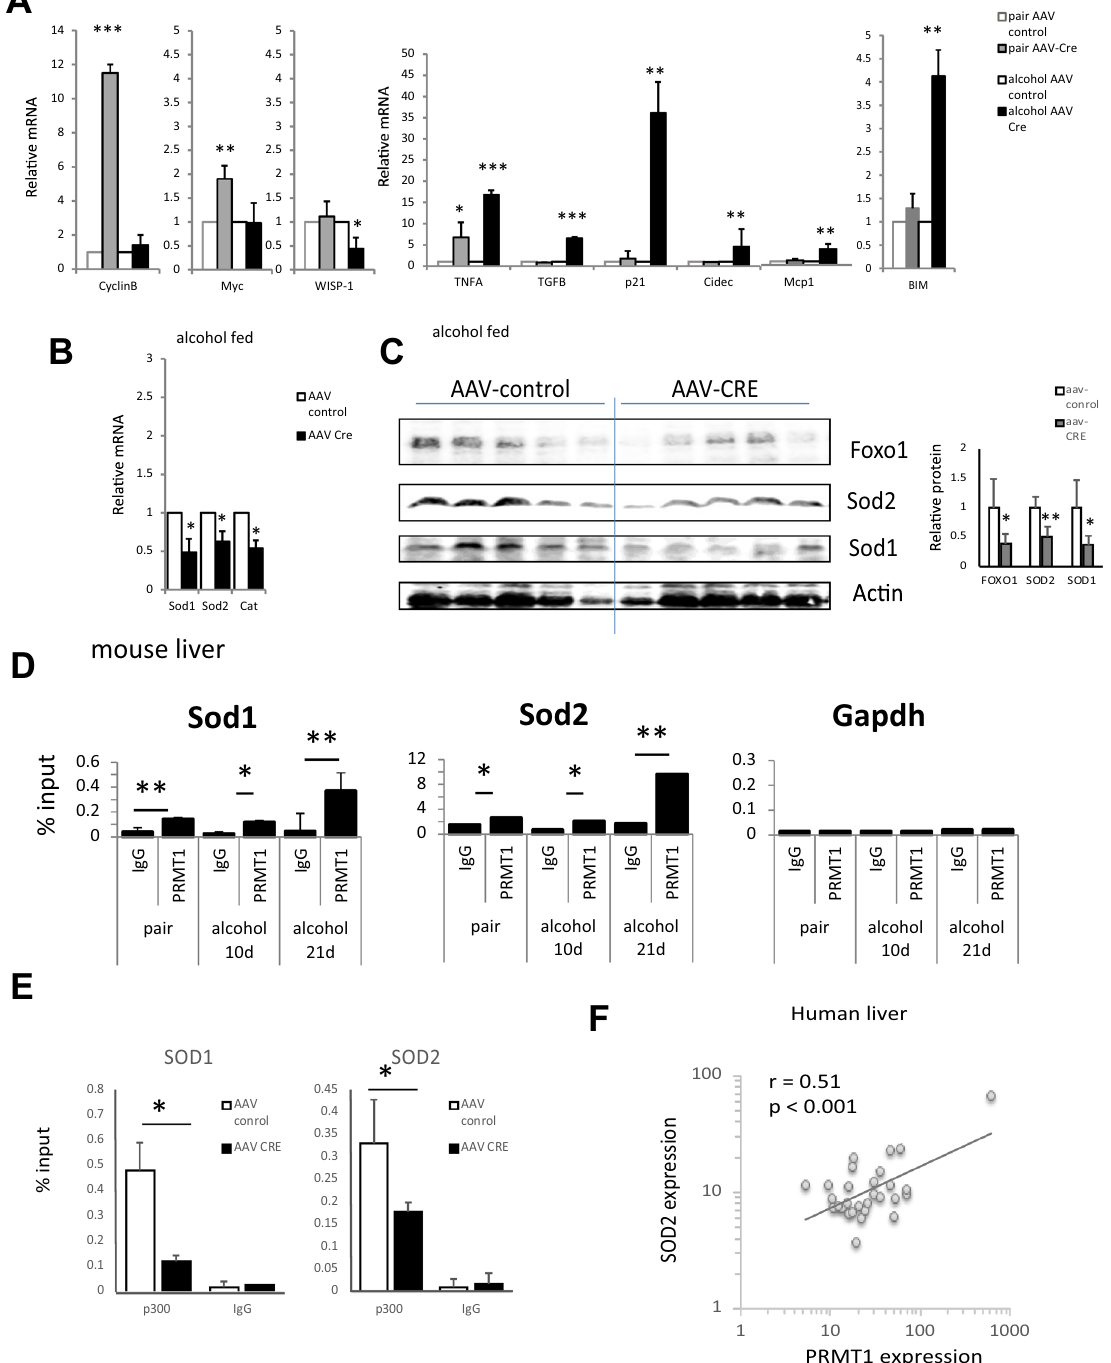
Figure 3. Alcohol alters PRMT1 function in the liver. ( A) Relative liver mRNA levels in mice fed alcohol or control liquid diet normalized to AAV-control mRNA as in Fig. 1; Data are presented as mean ± SD, N = 4–8 mice per group, * p < 0.05, ** p < 0.01, *** p < 0.001 Cre vs control; ( B) Relative liver mRNA levels in mice fed alcohol (6.4%) normalized to AAV-control mRNA; Data are presented as mean ± SD, N = 6–8 mice per group, * p < 0.05 Cre vs control; ( C) Western blot analysis of protein levels in these mice. Actin B is used as a loading control. N = 5 mice per group. Densitometry analysis is presented on the right. Data are presented as mean ± SD, * p < 0.05, ** p < 0.01 Cre vs control. ( D) Chromatin immunoprecipitation using anti-PRMT1 or IgG as a negative control from livers of the mice fed control (pair) or alcohol liquid diet for 10 days or 21 days. Data are presented as mean percent of input ± SD. N = 3. * p < 0.05, ** p < 0.01. ( E) Chromatin immunoprecipitation using anti-p300 or IgG as a negative control from livers of the mice fed alcohol liquid diet and received AAV-control or AAV-Cre vectors as in Fig. 1. Data are presented as mean percent of input ± SD. N = 3. ( F ) Correlation between PRMT1 expression and SOD2 expression in human livers from N = 41 liver